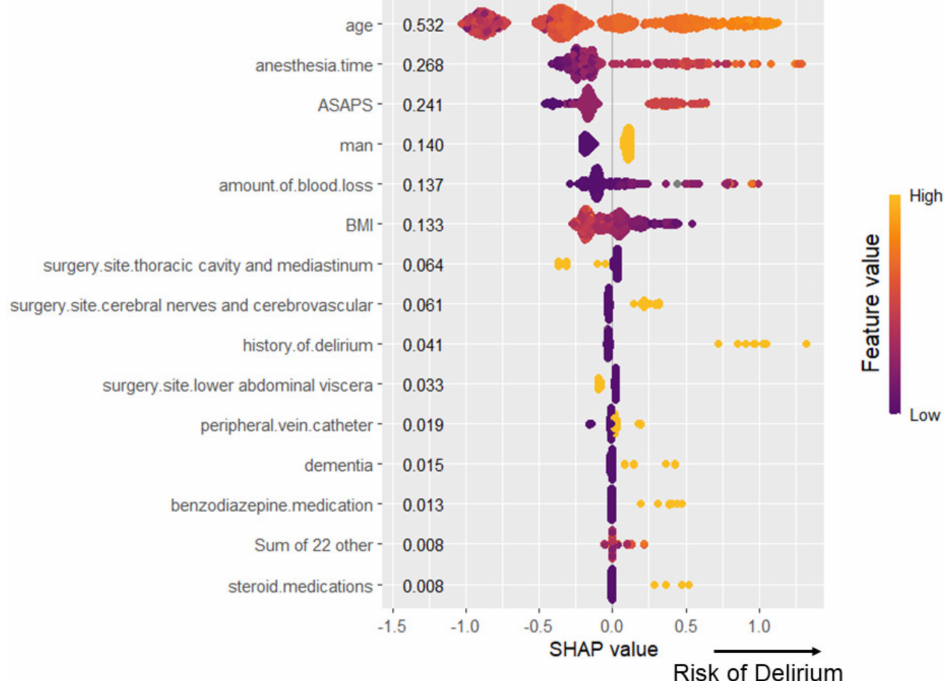
Figure 4. SHAP summary plot for Population C. SHAP summary plot of a 23-predictor XGBoost model. Each dot denotes a patient. Although there are 23 predictors, the one-hot encoding process results in 34 features when inputting into the XGBoost model. The top 15 predictive contributing features are shown. The x-axis shows the SHAP value attributed to the predictors. Higher SHAP values represent higher risk of delirium due to